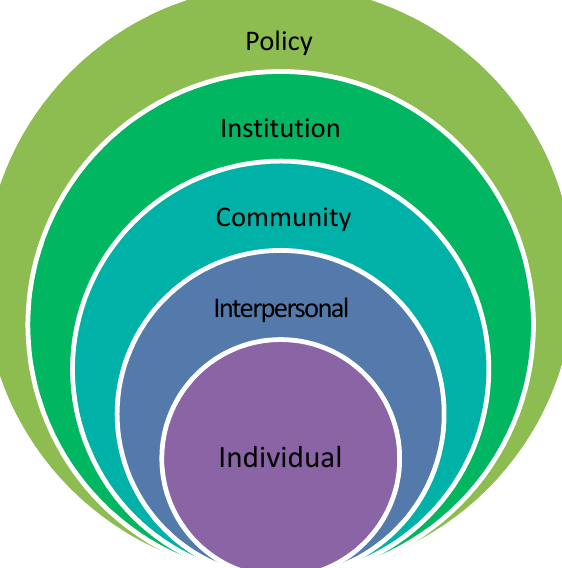
Figure 1. The socio-ecological framework. Source: Adapted from Bronfenbrenner (1999) [29].